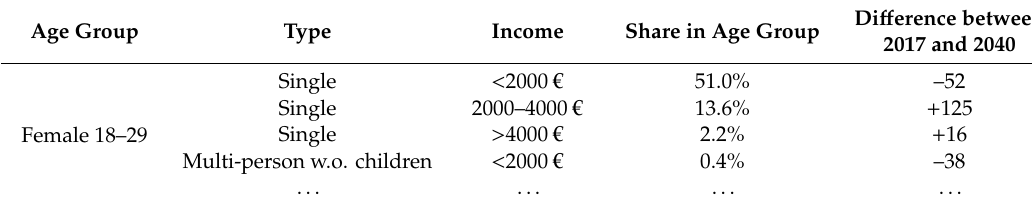
Table A5. Projections of household characteristics by age groups in